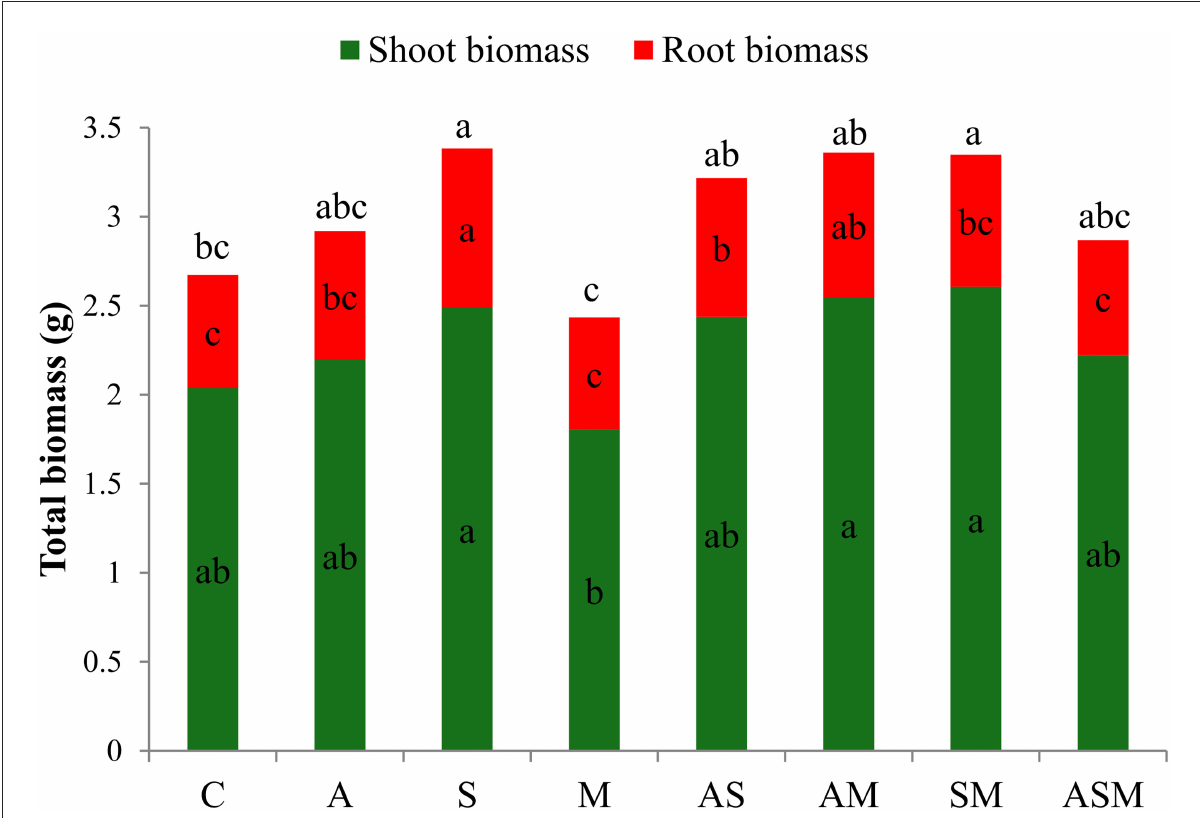
FIGURE1 Effects of combined inoculation effects of root endophytic fungi on plant biomass of A. adsurgens seedlings. Different lowercase letters indicate significant differences ( p < 0.05). C, non-inoculated control; A, inoculation with Alternaria chlamydospora ; S, inoculation with Sarocladium kiliense ; M, inoculation with Monosporascus sp.; AS, co-inoculation of Alternaria chlamydospora and Sarocladium kiliense ; AM, co-inoculation of Alternaria chlamydospora and Monosporascus sp.; SM, co-inoculation of Sarocladium kiliense and Monosporascus sp.; ASM, combination inoculation of the three